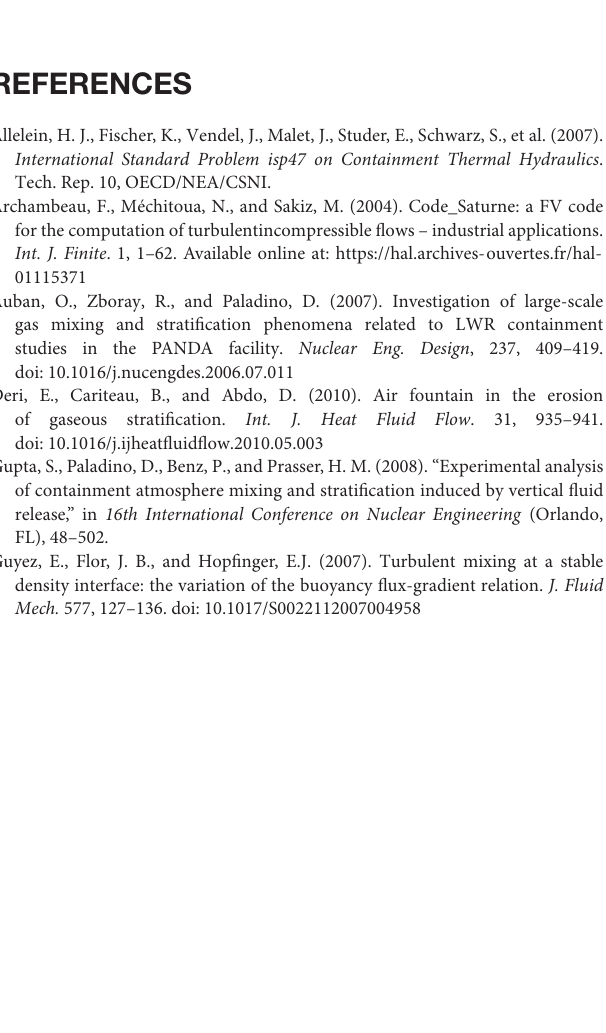
Supplementary Table 1 | Data of calculation